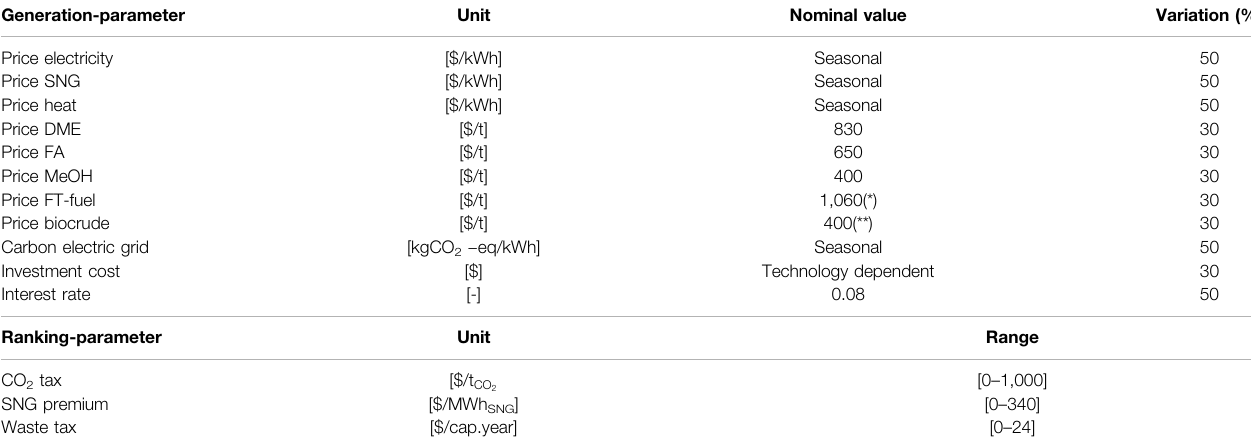
TABLE 2 | Market considerations and parameter uncertainty range; * diesel price; ** half of crude oil price. Uniform distribution are assumed for all parameters.